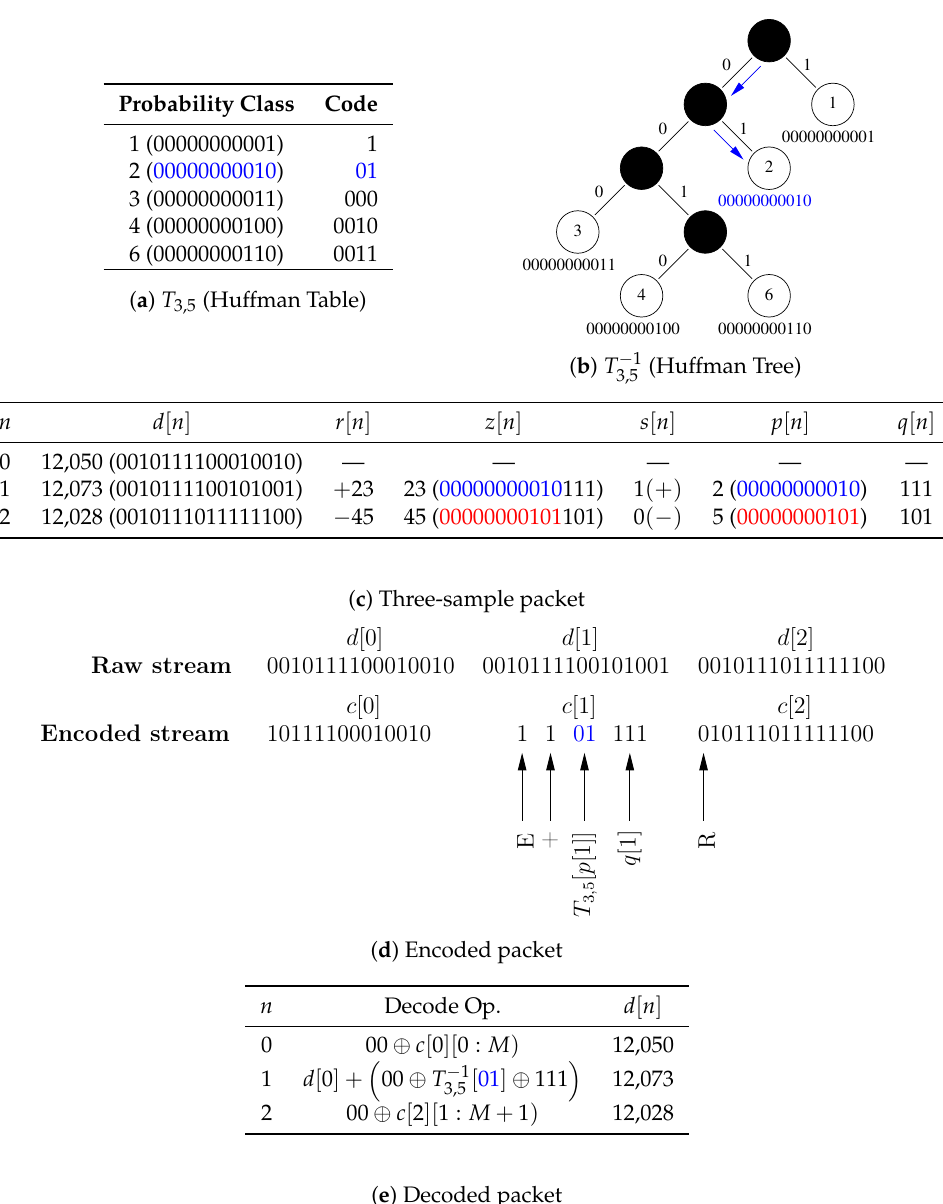
Figure 3. A simulated example of encoding and decoding a three-sample packet with a 14-bit single data channel. ( a ) The compression table stored on the MCU ( M = 14, m = 3, k = 5), which maps the 11 upper bits of the magnitude of residuals to Huffman codes. ( b ) The tree stored on the